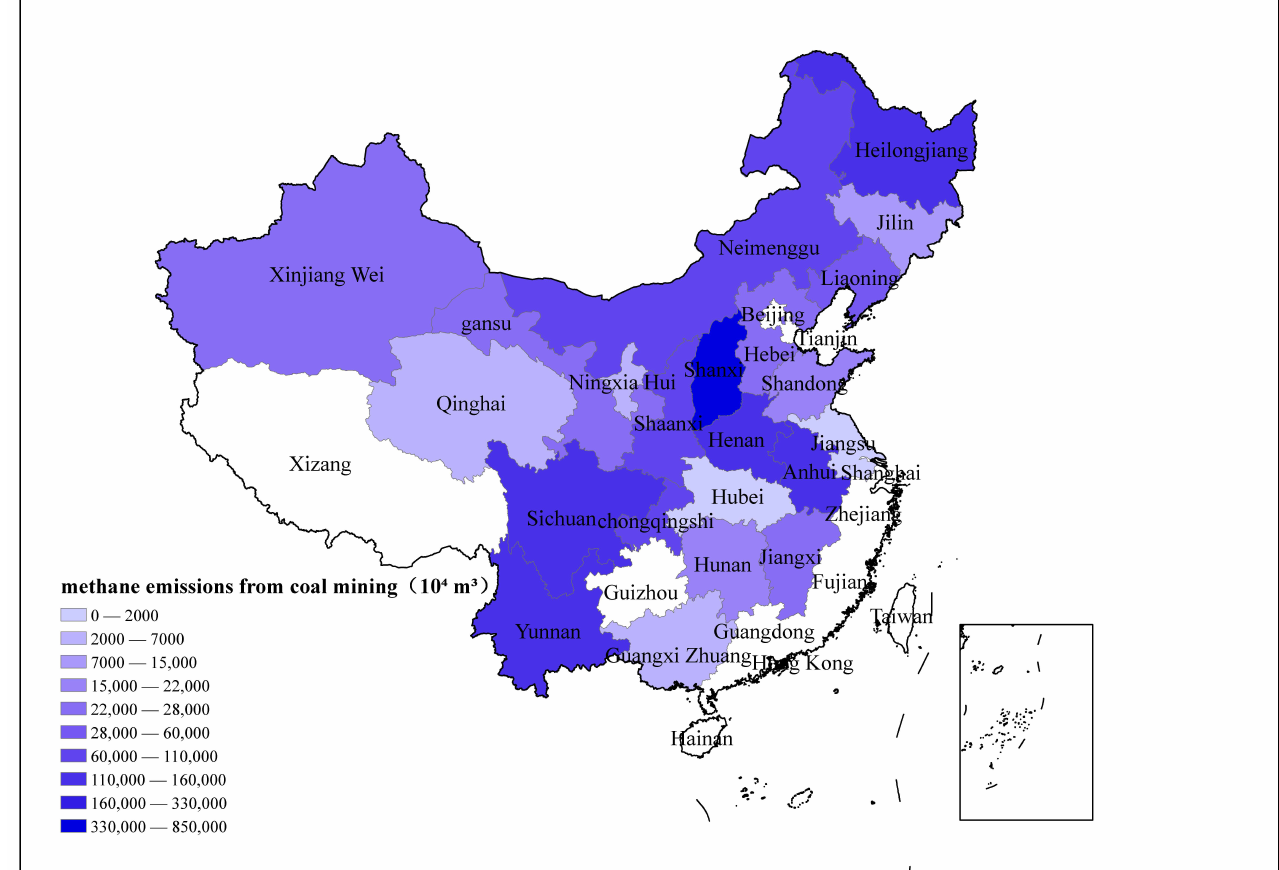
Figure 3. CH 4 emissions of the coal mining industry in various